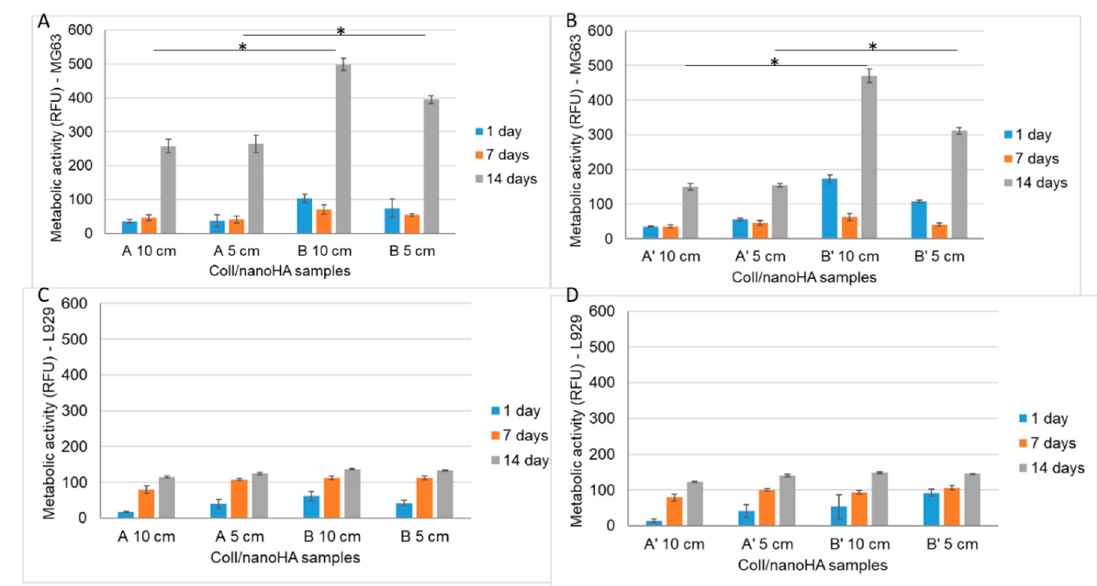
Figure 6. Metabolic activity of MG63 ( A , B ) and L929 ( C , D ) when in direct contact with samples A, B, A’ and B’ after 1, 7 and 14 days of incubation, as estimated by a Resazurin assay. The control was carried out in TCPS, and was considered to have a cell viability of 100%. Statistical differences between samples from different batch, * p <